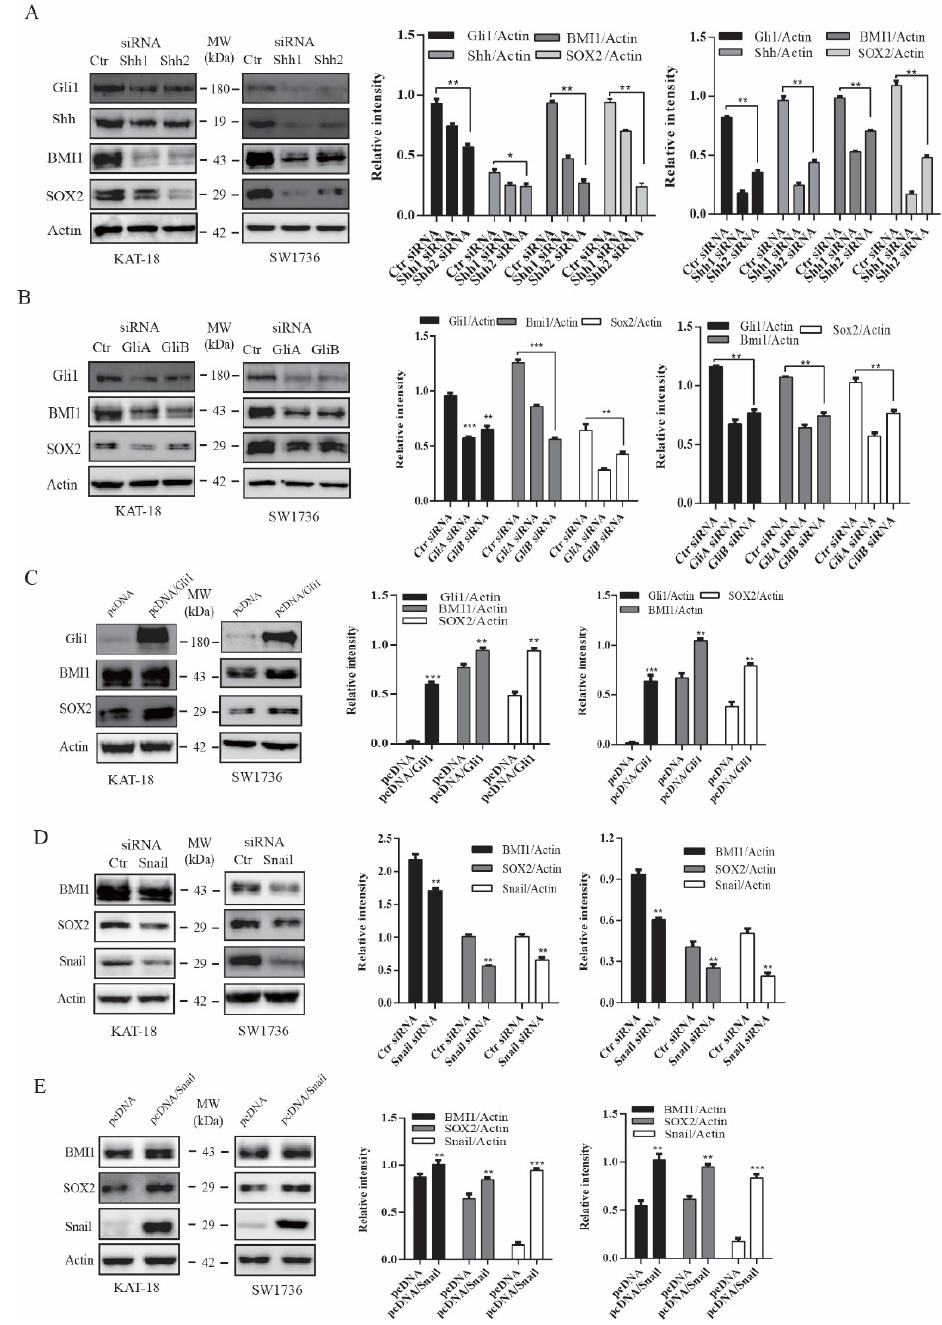
Figure 2. The Shh pathway regulated BMI1 and SOX2 expression. KAT-18 and SW1736 cells transfected with Shh ( A ), Gli1 ( B ), or Snail ( D ) siRNA or transfected with an empty vector or the vector encoding Gli1 ( C ) or Snail ( E ) were analyzed for Shh, Gli1, BMI1, and SOX2 expression by Western blot. Scramble siRNA was used as a negative control. Actin was included as a loading control. Relative protein levels were analyzed by quantification of the density of the protein bands with NIH Image-J software and presented as bar graphs. Data are mean ± SD of three experiments. * p < 0.05, ** p < 0.01, *** p < 0.001 compared to the